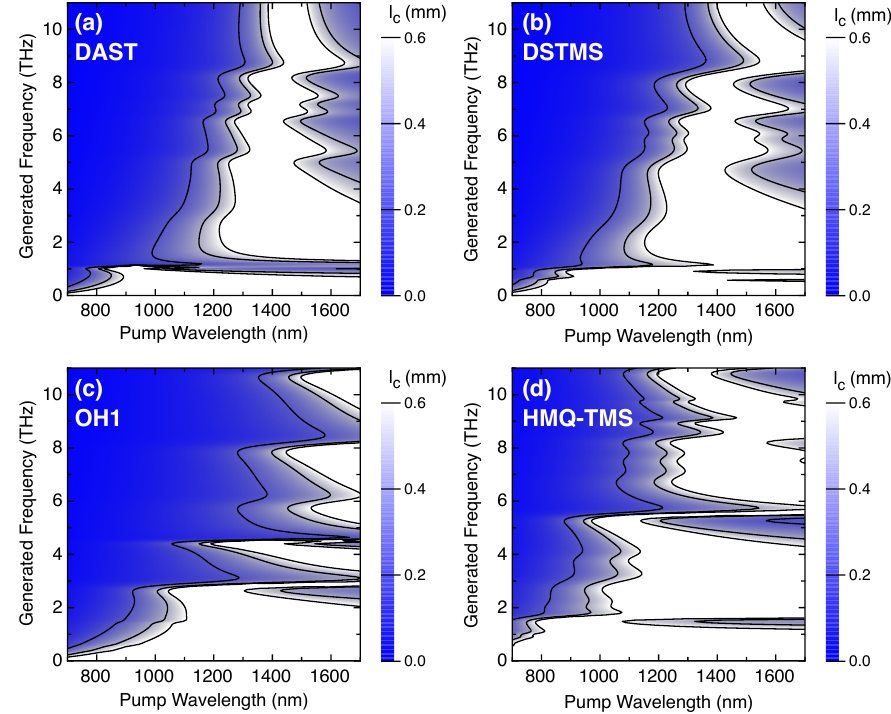
Figure 9. Coherence length l c for THz-wave generation in ( a ) DAST; ( b ) DSTMS; ( c ) OH1; and ( d ) HMQ-TMS as a function of the pump optical wavelength λ and the generated THz frequency f . The white area represents coherence lengths larger than 0.6 mm and therefore best velocity